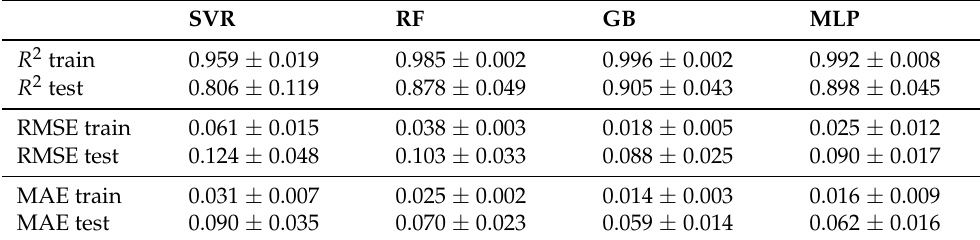
Detailed metrics ( R 2 , RMSE and MAE) obtained for SVR, RF, GB and MLP with optimized HPs.